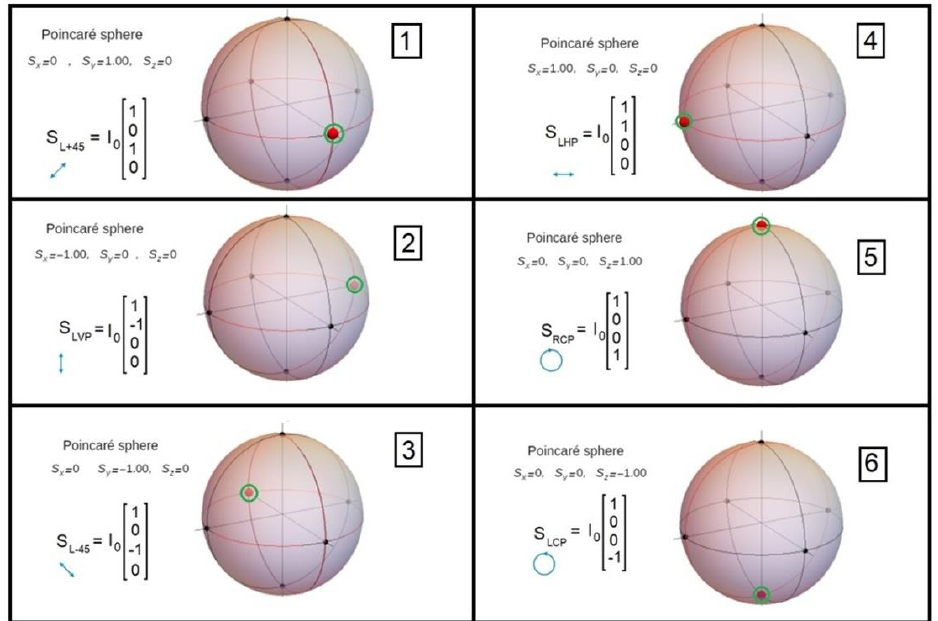
Figure 5. Stokes vectors and Poincaré sphere for the light polarization observed in the pattern of a dipolar magnetic field for a Ferrocell. Each number represents a type of light polarization, as follows: ( 1 ) 45 degrees positive polarization, ( 2 ) horizontal polarization, ( 3 ) negative 45 degrees polarization, ( 4 ) vertical polarization, ( 5 ) right-hand circular polarization, and ( 6 ) left-hand circular polarization.